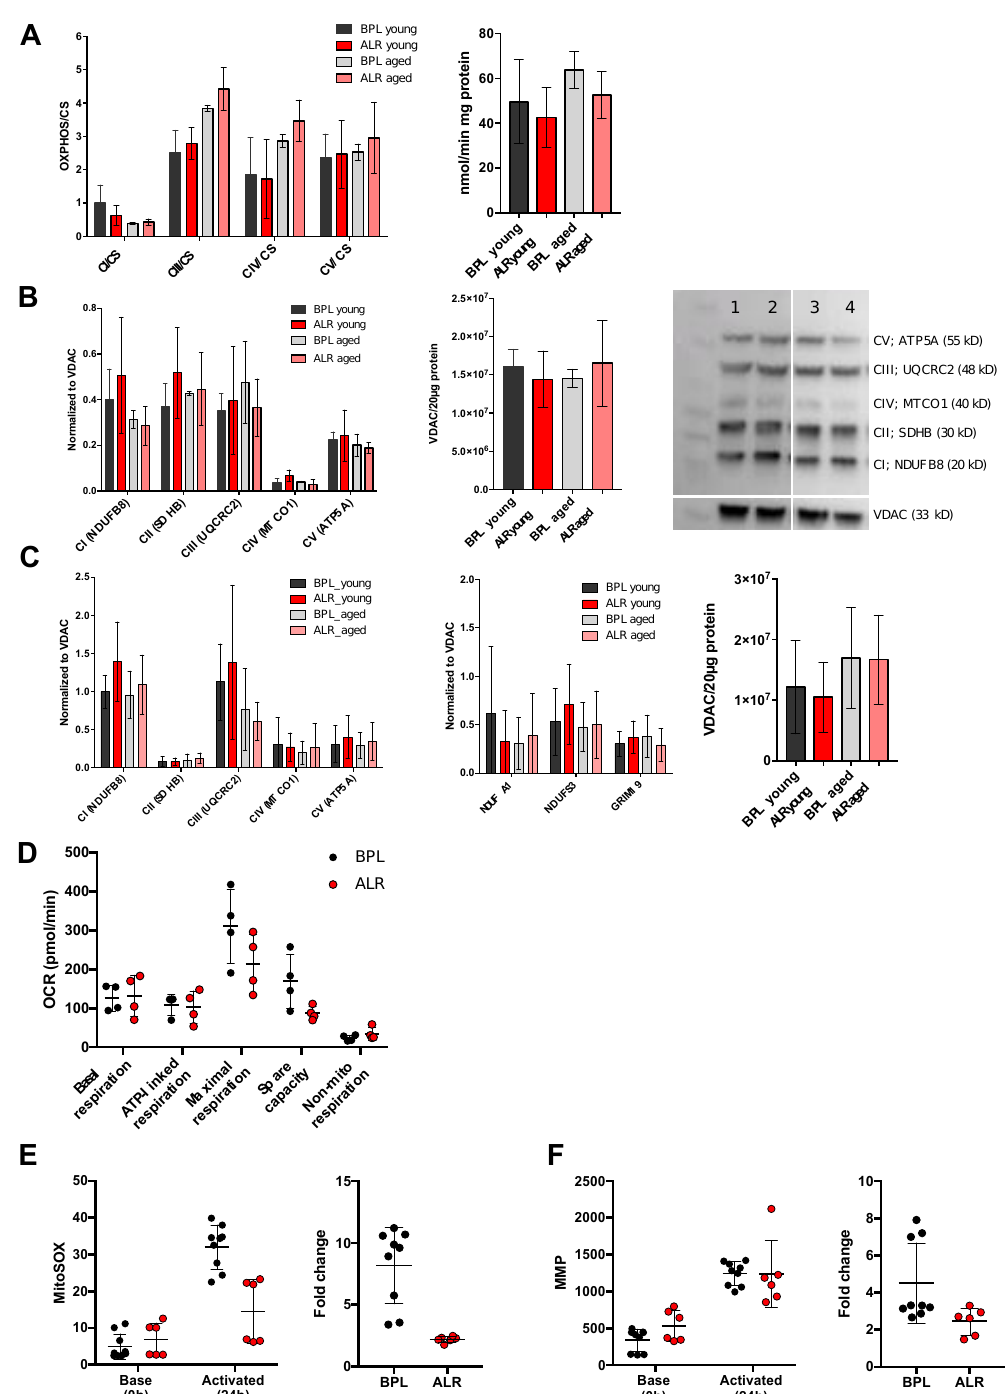
Figure 2. Mitochondrial functional consequence of the mutation in mt-Nd2 in B6-mt ALR female mice. ( A ) Oxidative phosphorylation (OXPHOS) complex activities were measured in liver mitochondria isolated from B6-mt BPL and B6-mt ALR mice. OXPHOS activities were normalized to each citrate synthase (CS) activities (left panel). No significant difference in activities was detected between the strains in both age groups. Activities in complex III normalised to CS activities were increased in ageing in both strains, however, no difference was observed between strains. CS activities are shown in the right panel. BPL: B6-mt BPL ; ALR; B6-mt ALR ; young: 3–4-month-old mice; old: 18–22 months old. n = 15 (BPL, young), n = 14 (ALR, young), n = 4 (BPL, aged), and n = 3 (ALR, aged). Descriptive p = 0.0011 (BPL, young vs. BPL, aged), descriptive p = 0.0004 (ALR, young vs. ALR, aged), one-way ANOVA. ( B ) Quantified values of Western blotting of liver samples demonstrated comparable protein levels of mitochondrial OXPHOS subunits (left panel). n = 3/strain (young), n = 4/strain (aged).